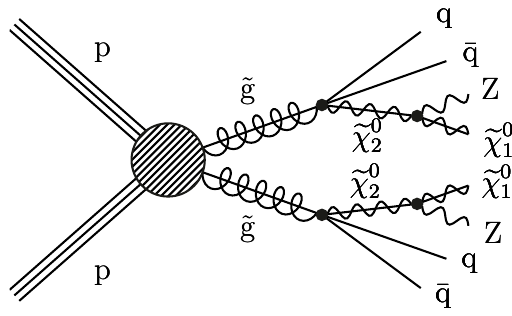
Figure 1 . Signal diagram for the T5ZZ simpli(cid:12)ed model process. The assumed small mass splitting between